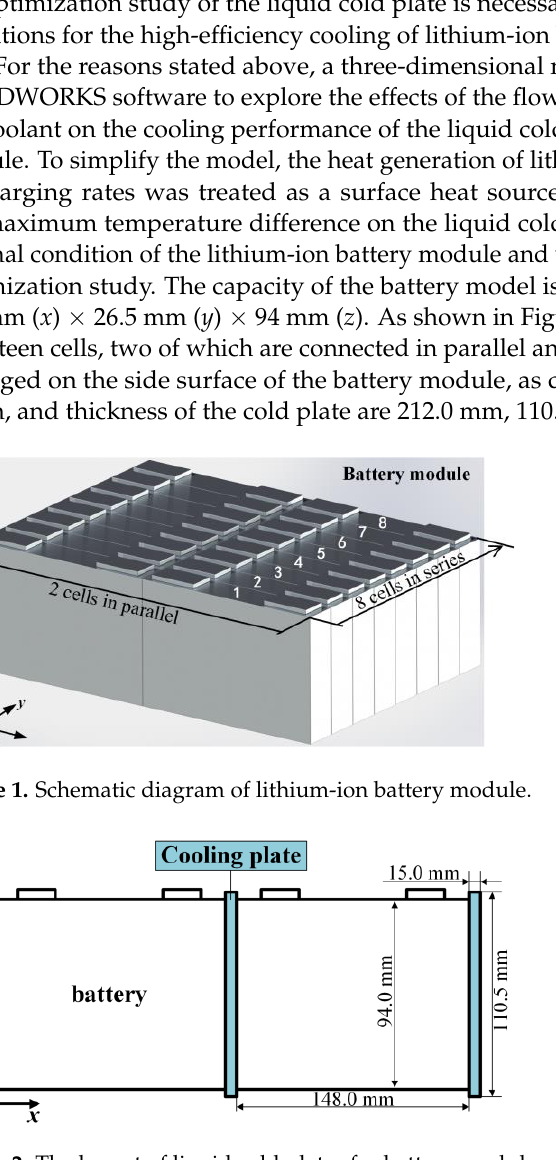
Figure 2. The layout of liquid cold plates for battery module